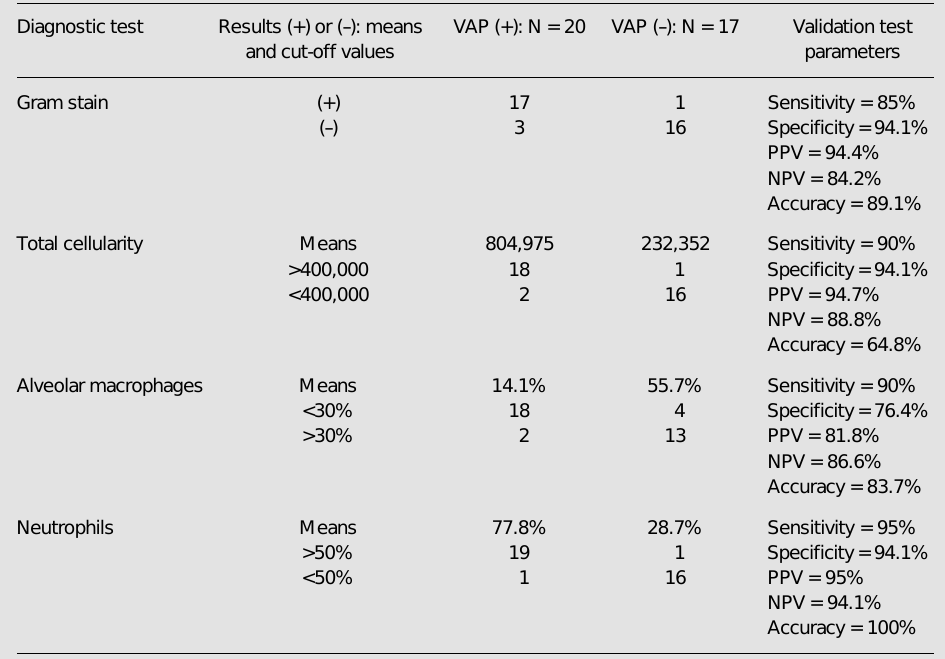
Table 2. Validation test for the other bronchoalveolar lavage variables. The gold standard parameters were open lung biopsy histopathological pattern for pneumonia plus quantitative culture of a lung tissue